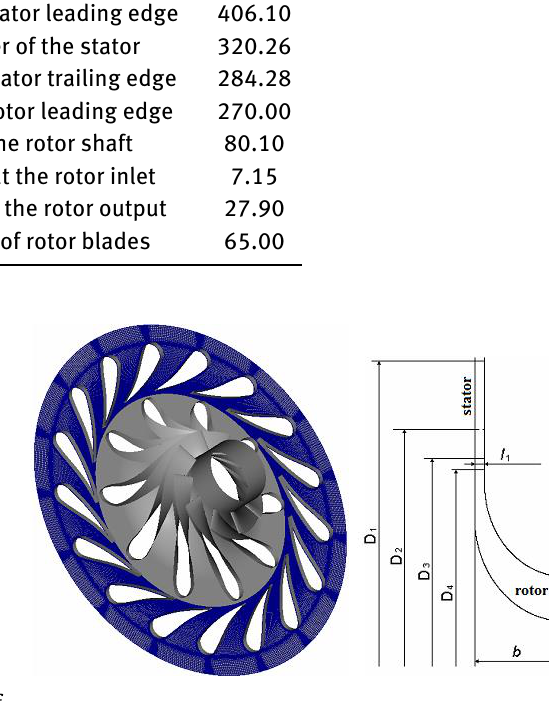
Figure 5. Turbine of turbo expander Figure 5: Turbine of turbo expander Table 1. Basic geometric dimensions of the flow part MP-U2 in the Timofeevskii oil gas condensate field (Fig.